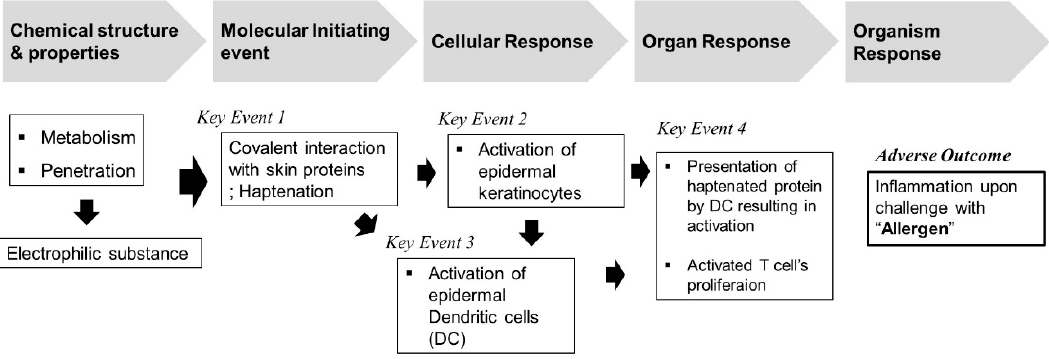
Figure 5. Overview of adverse outcome pathway (AOP) for skin sensitization.